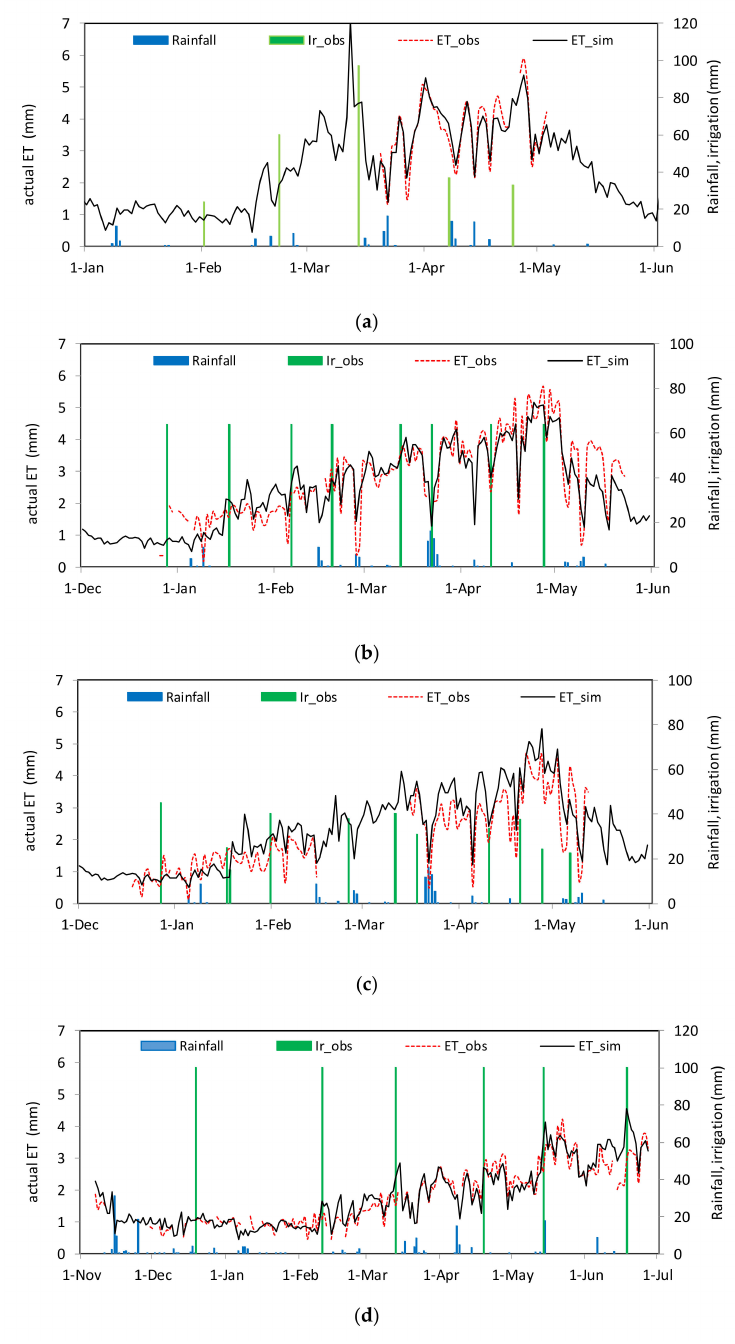
Figure 4. Comparison between measured and simulated actual ET after model calibration over three wheat fields: C1 ( a ) in 2002–2003, C2 ( b ) and C3 ( c ) in 2015–2016 and the olive trees C4 ( d ) in